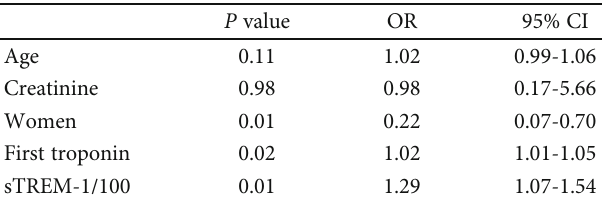
Figure 2: Median plasma levels of soluble TREM-1 in acute coronary syndrome compared to nonspeci fi c chest pain and healthy control groups (using univariate logistic regression). Table 4: Logistic regression for developing ACS compared to noncardiac chest pain.